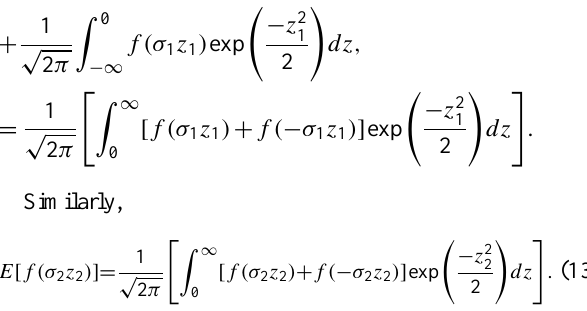
Fig. 2. Graphical representation of the inequalities in Eq. (11). ¯ x is the center point of both intervals [ a,b ] and [ c,d ] .